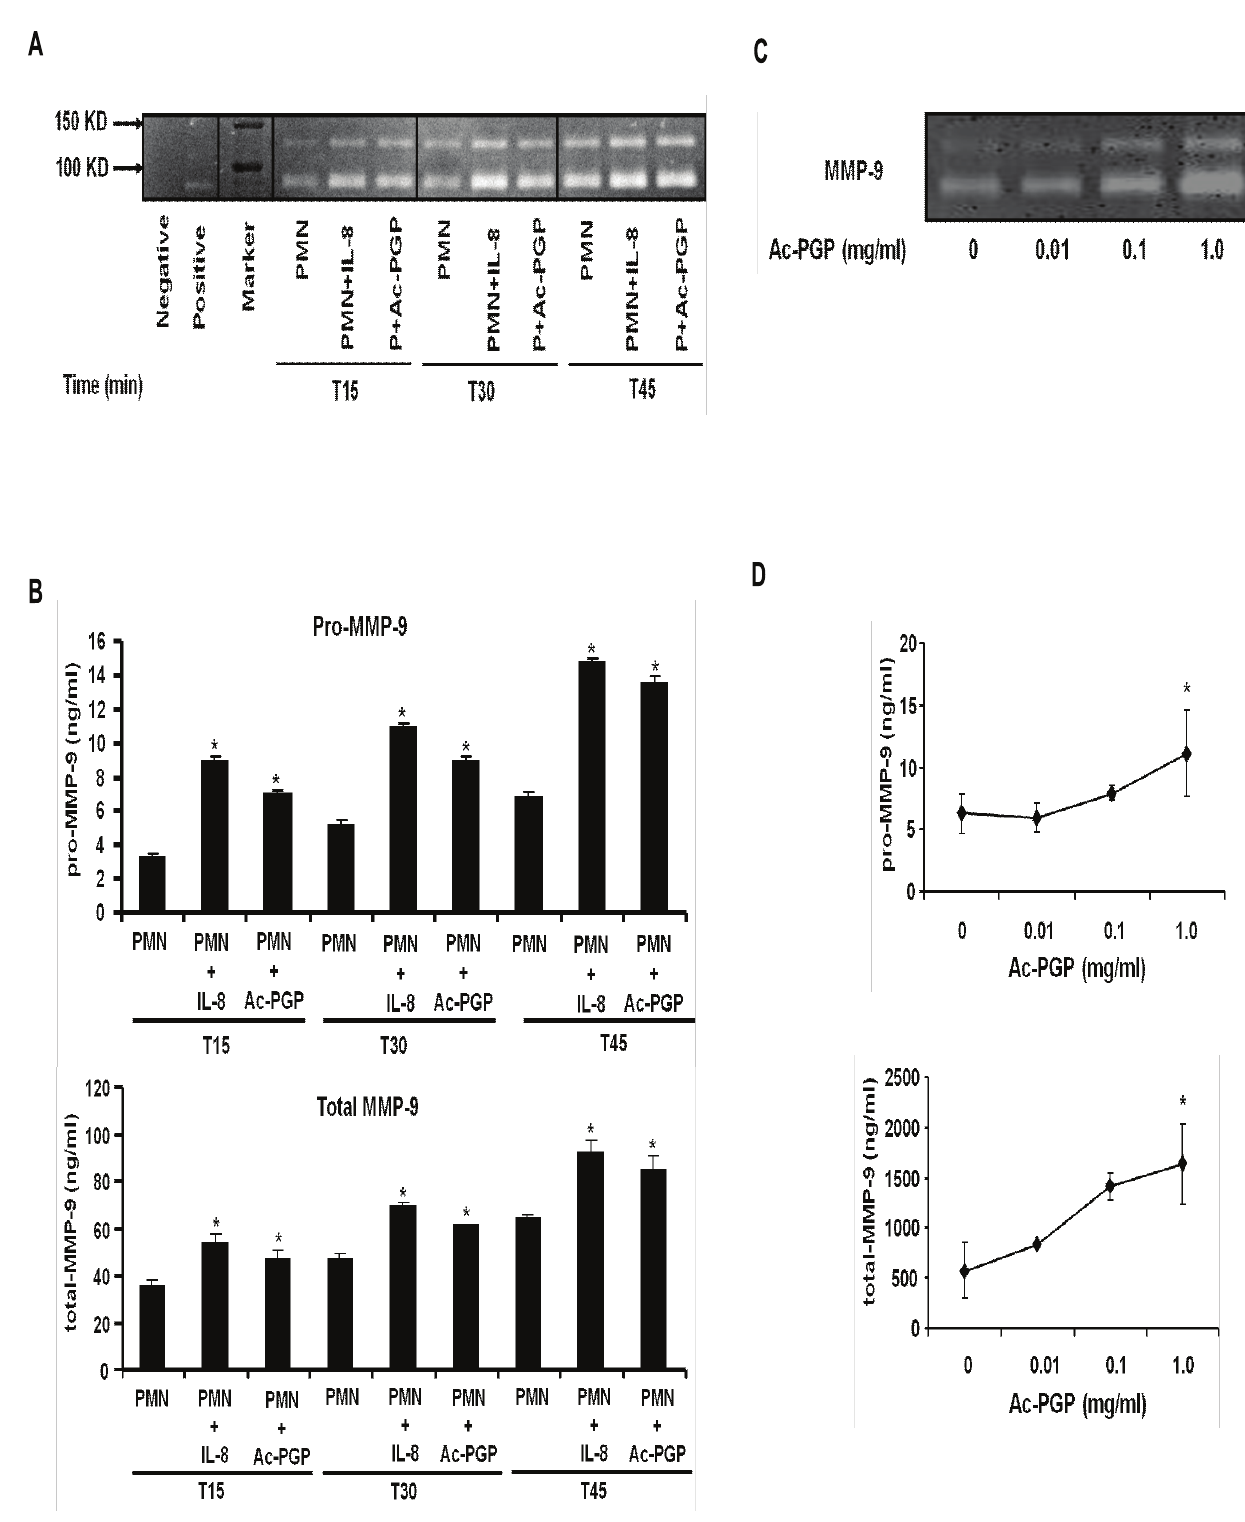
Figure 1. Increased MMP-9 activity in culture supernatants from human PMNs stimulated with Ac-PGP. Human PMNs isolated from peripheral blood were stimulated with Ac-PGP and IL-8 for different times and then supernatants were collected for MMP-9 assay. A . The detection of gelatinolytic activity in a time-dependent manner by g elatin zymography representative of three gels. B . The quantification of specific MMP-9 activity in a time-dependent manner by ELISA-based assay. C . The detection of gelatinolytic activity in a dose-dependent manner by g elatin zymography representative of three gels. D . The quantification of MMP-9 activity in a dose-dependent manner by ELISA-based assay. *p , 0.05 , compared with PMN only within same time point.